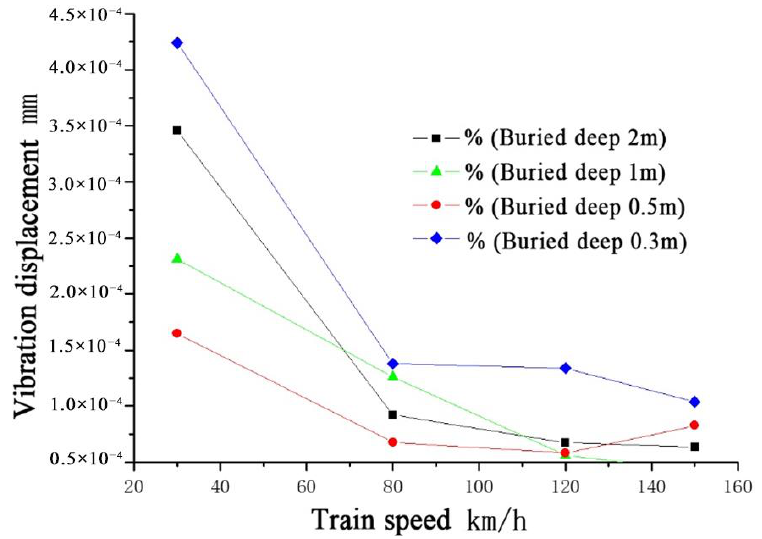
Figure 5. Foundation soil vibration displacement-train speed curve.